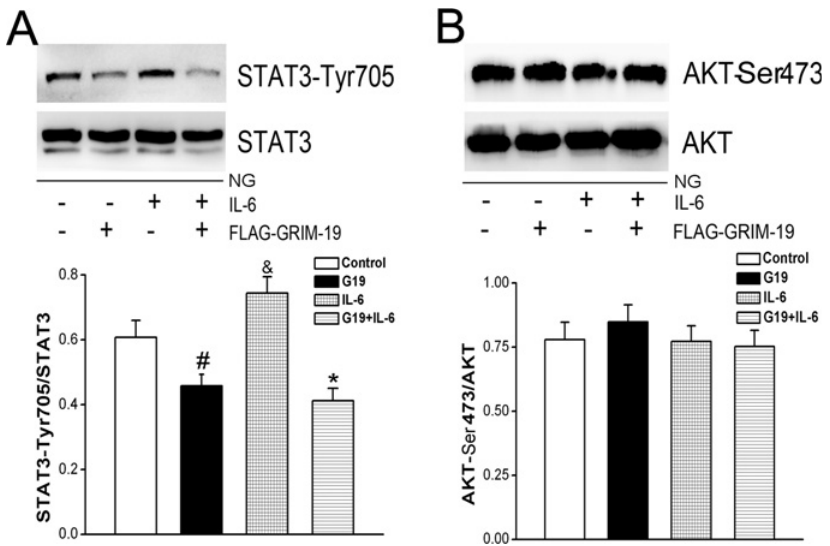
Fig 4. The effects of IL-6 on STAT3 activation were investigated in normal glucose cultured HeLa cells that infected with or without lentivirus to over-express GRIM-19. Both phosphorylation levels of STAT3 (shown in panel A) and Akt (shown in panel B) were measured by western blotting relative to the total expression of STAT3 or Akt, respectively. Data are expressed as the mean ± SD (of three independent experiments). * , denotes a P < 0.05 compared with the same IL-6 stimulated HeLa cells without GRIM-19 over-expression. #, P < 0.05 compared with HeLa cells without GRIM-19 over-expression.&, P < 0.05 compared with HeLa cells without GRIM-19 over-expression or IL-6